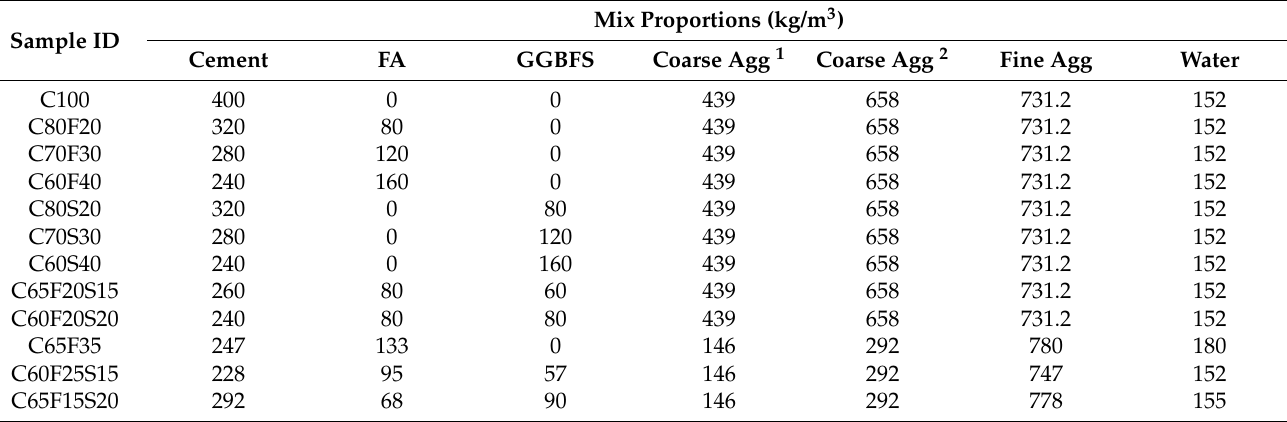
Table 2. Mix proportions of concrete by